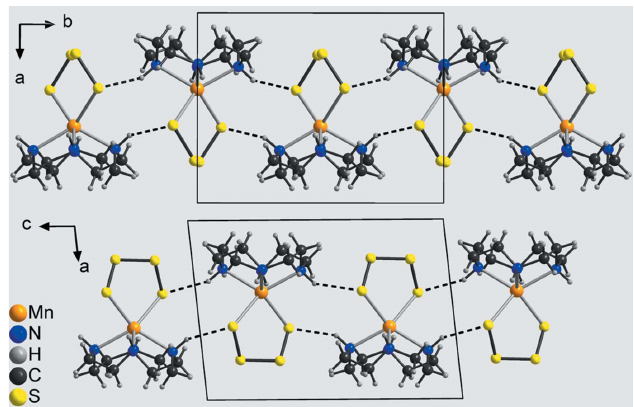
Figure 4 View of the chains running along the b - (top) and the c -axis (bottom) directions with intermolecular N—H (cid:2)(cid:2)(cid:2) S hydrogen bonds shown as dashed lines.